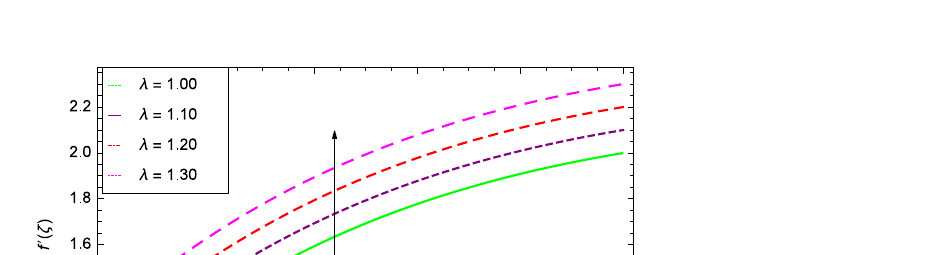
Figure 10. Parameter effect on velocity f ′ (ζ) profile.